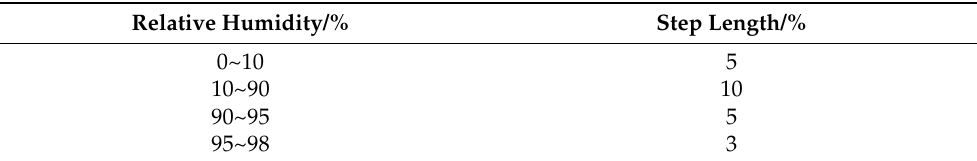
Table 1. Relative humidity range and step lengths adopted in the dynamic water vapor sorption cycle. Relative Humidity/% Step Length/%